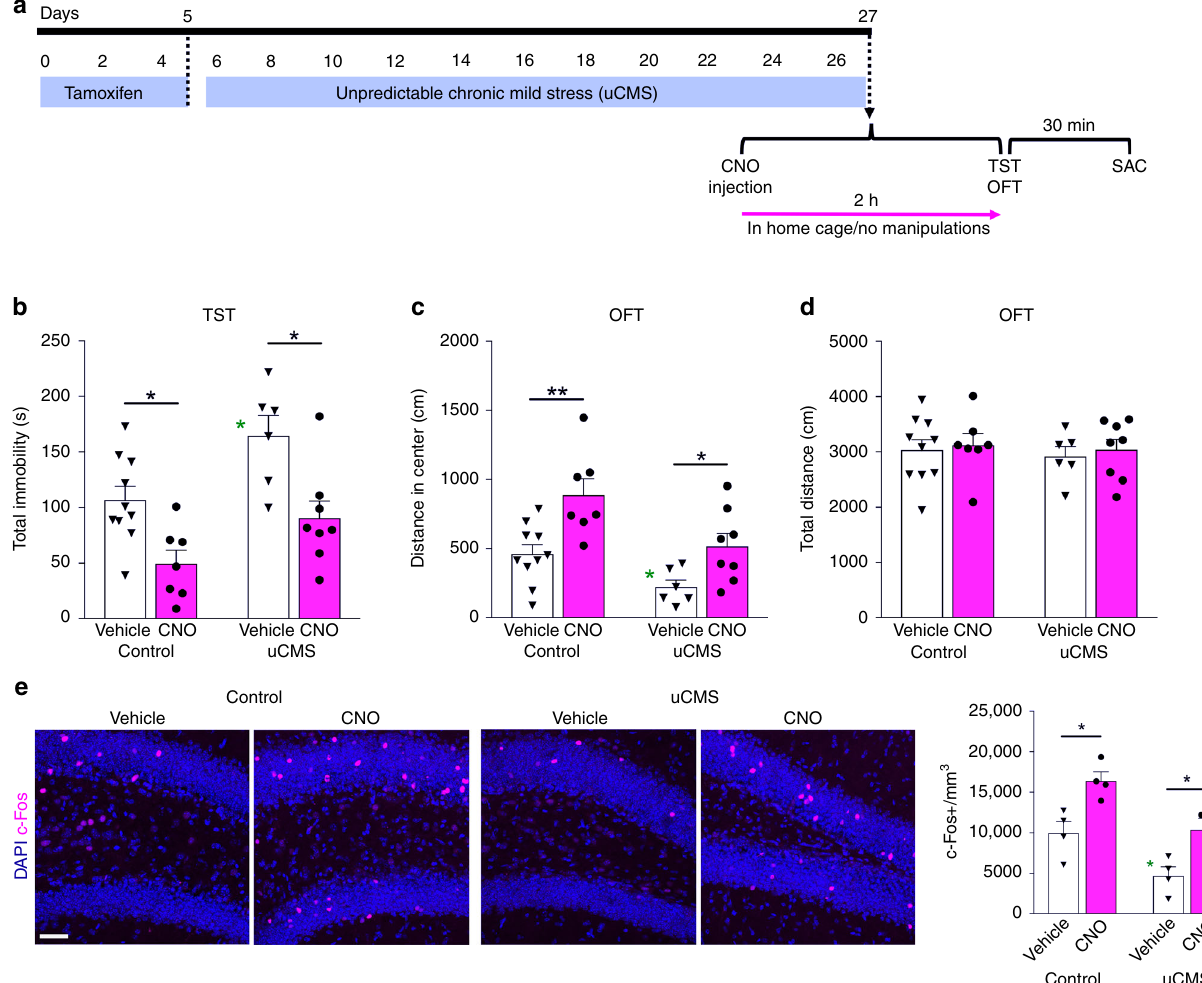
Fig. 5 Acute activation of newborn dentate gyrus neurons reverses the behavioral effects of unpredictable chronic mild stress (uCMS). a Timeline representing the experimental design for determining whether acutely enhancing the activity of newborn neurons in adult hippocampus reverses the behavioral effects of unpredictable chronic mild stress (uCMS) in Ascl1-CreER TM ;R26 LSL − hM3Dq mice. b Total time-spent immobile in tail suspension test, a measure of depression-like behavior (uCMS F 1,27 = 11.23, ** P = 0.002; CNO F 1,27 = 19.93, *** P = 0.0001; Interaction F 1,27 = 0.313, P = 0.581; Tukey posthoc test Control + Vehicle versus uCMS + Vehicle * P < 0.05). c Center exploration distance in open- fi eld test, a measure of anxiety-like behavior (uCMS F = 12. P = 0.002; CNO F = 17.04, *** P = 0.0003; Interaction F = 0.564, P = 0.459; Tukey posthoc test Control + Vehicle versus uCMS + 1,27 1, ** 1,27 1,27 Vehicle * P < 0.05). d Total distance in open- fi eld test, measure of locomotor activity (uCMS F = 0.242, P = 0.627; CNO F = 0.267, P = 0.609; 1,27 1,27 Interaction F 1,27 = 0.008, P = 0.930). e Representative images and quanti fi cation of c-Fos expression in the dentate gyrus (uCMS F 1,12 = 19.19, *** P = 0.0009; CNO F 1,12 = 22.01, *** P = 0.0005; Interaction F 1,12 = 0.088, P = 0.771; Tukey posthoc test Control + Vehicle versus uCMS + Vehicle * P < 0.05). Data are presented as means ± s.e.m. and analyzed by two-way ANOVA. Scale bar 50 μ m Hippocampal slice electrophysiology . Mice were anesthetized with iso fl urane followed by ketamine/xylazine, then rapid cardiac perfusion was performed using ice-cold sucrose arti fi cial cerebrospinal fl uid (ACSF) containing the following (in mM): 85 NaCl, 2.5 KCl, 1.25 NaH 2 PO 4 , 25 NaHCO 3 , 25 glucose, 75 sucrose, 0.5 CaCl 2 , and 4 MgCl 2 , equilibrated with 95% O 2 /5% CO 2 before mice were decapitated. Brains were rapidly removed and placed in the same ice-cold sucrose ACSF as described above. Coronal hippocampal slices (250 μ m thick) were pre- pared using a Leica 1000S vibratome and transferred to a heated (28 – 32°C) holding chamber containing the same sucrose ACSF, which was gradually exchanged for regular ACSF containing the following (in mM): 125 NaCl, 2.5 KCl, 1.25 NaH 2 PO 4 , 25 NaHCO 3 , 25 glucose, 2 CaCl 2 , and 1 MgCl 2 , equilibrated with 95% O 2 /5% CO 2 at room temperature. After being incubated with regular ACSF for at least 1h, slices were transferred to a recording chamber and perfused con- tinuously with oxygenated regular ACSF at a fl ow rate of 2mlmin − 1 . Hippocampal dentate granule neurons were visualized under differential interference contrast optics and hM4Di expressing neurons were identi fi ed based on YFP reporter fl uorescence. Recording electrodes were made from borosilicate glass pipettes and Table 1). Stressors were performed on a randomized schedule, and each stress was had a resistance of 3.5 – 6.5M Ω when fi lled with an internal solution containing the administered for a minimum of 2h, except light cycle disturbances and restraint following (in mM): 130 K-gluconate, 10 KCl, 10 HEPES, 4 Mg-ATP, 0.3 Na-GTP, stress. At the end of each daily stress period, animals were replaced into clean cages NATURE COMMUNICATIONS| (2019) 10:3768